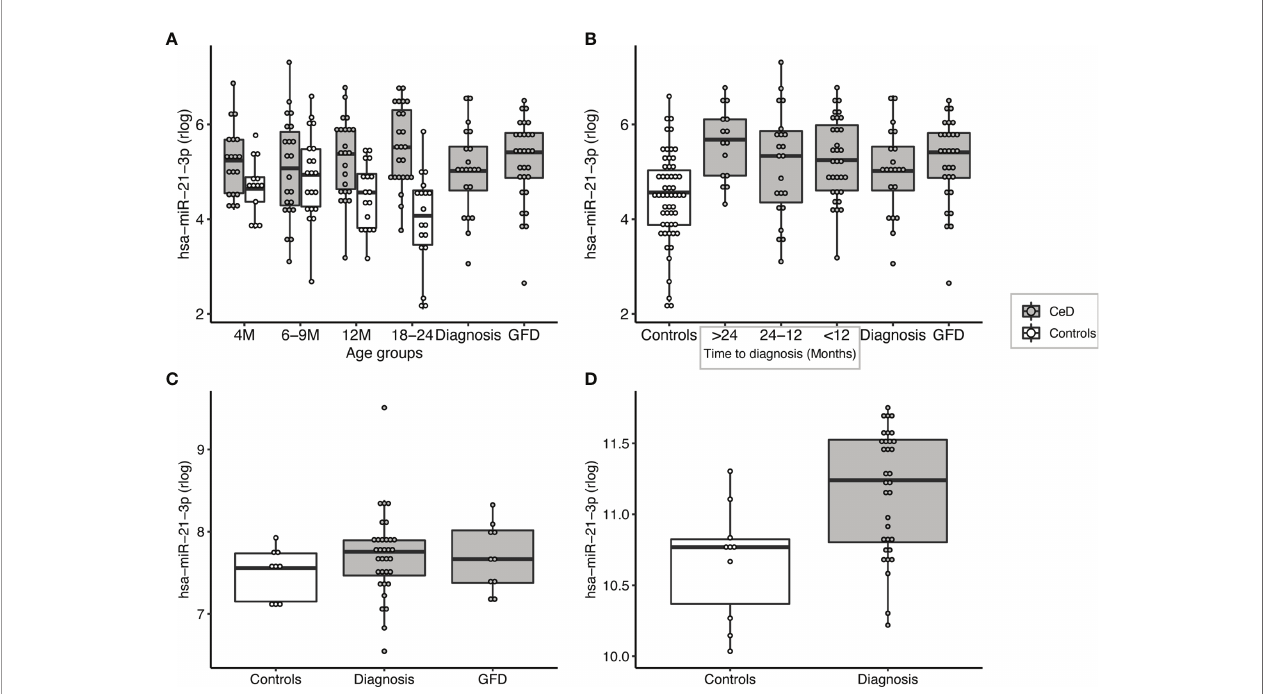
FIGURE 5 | miR-21-3p can be detected at high levels in pre-diagnostic samples of patients but not in age-matched controls and is signi fi cantly upregulated in the small intestinal biopsies of CeD patients. (A) PreventCD cohort: grouped by age of sampling (M=Months). (B) PreventCD cohort: pre-diagnostic (IgA anti- transglutaminase negative) samples of CeD patients are grouped by time till seroconversion: more than 24 months before seroconversion (>24), between 24-12 months before seroconversion (24-12), less than 12 months before seroconversion (<12), or at diagnosis (taken at seroconversion or at time of biopsy) and 6 months after starting GFD. Controls: all samples of the PreventCD controls. (C) Circulating miR-21-3p in the Milano-Bicocca cohort (circulation). (D) miR-21-3p expression in small-intestinal biopsies in the Milano-Bicocca